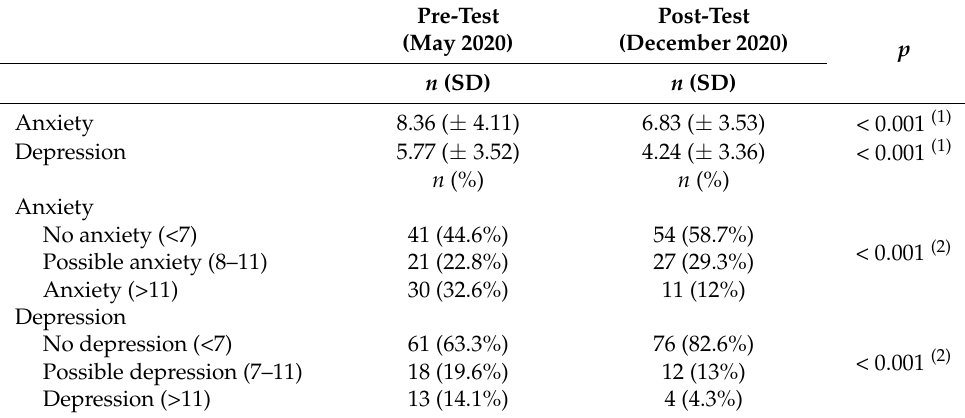
Table 2. T0–T1 mean anxiety and depression scores.